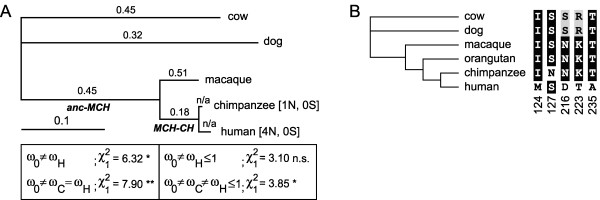
Phylogenetic tree and Ka/Ka ratio forCernunnos-XLF coding sequences. A. Phylogenetic tree and Ka/Ka ratio for Cernunnos-XLF mammalian coding sequences. Phylogenetic tree obtained by the free ratio codon model in PAML. The ancestral branches from Fig. 1A are indicated by italics. Branch labels mark the ω = Ka/Ks ratios for corresponding branches. For the human and chimpanzee branches we could not calculate the Ka/Ks ratio and instead we list the number of synonymous (S) and nonsynonymous (N) changes in square brackets. The boxes list selected tested hypotheses. The Ka/Ks rate is designated as ωH for the in the human lineage, ωC for the chimpanzee lineage, and ω0 for all other lineages. A single asterisk indicates P < 5%, χ21 = 3.84, double asterisk indicates P < 1%, χ21 = 6.63. The left box tests the hypotheses that the Ka/Ks ratio for the human lineage is the same as for the rest of the tree (rejected at P < 5%), and that both human and chimpanzee lineages have the same Ka/Ks ratio shared with other branches (rejected at P < 1%). The right box shows tests Ka/Ks ≤ 1 for the human lineage (not significant) and for both human and chimpanzee lineages (rejected at P < 5%). B. Amino acid residues for five critical positions changed between human and chimpanzee. The tree also includes orthologous positions from the orangutan Cernunnos-XLF protein. The figure shows conservation of the critical positions in macaque and orangutan, which represents the most likely ancestral state. Four human and one chimpanzee changes indicated in the figure represent the most parsimonious scenario of Cernunnos-XLF evolution.